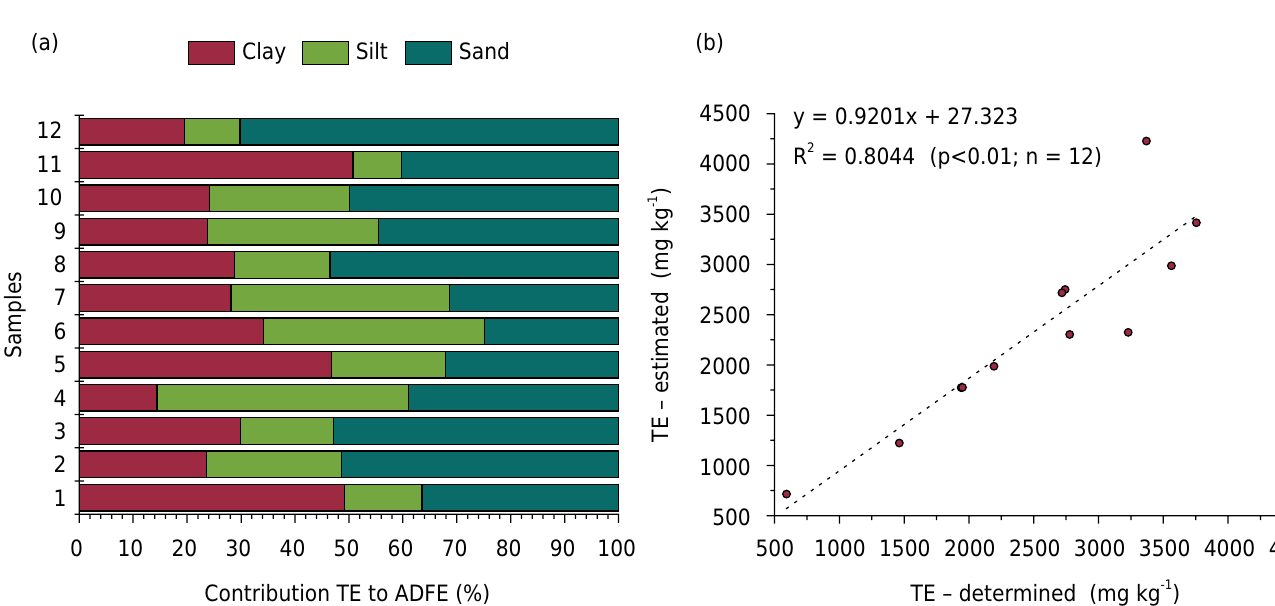
Figure 11. Estimated contribution of sand, silt, and clay fractions to the total trace elements (TE) contents (a), and correlation between estimated and determined total TE in the ADFE